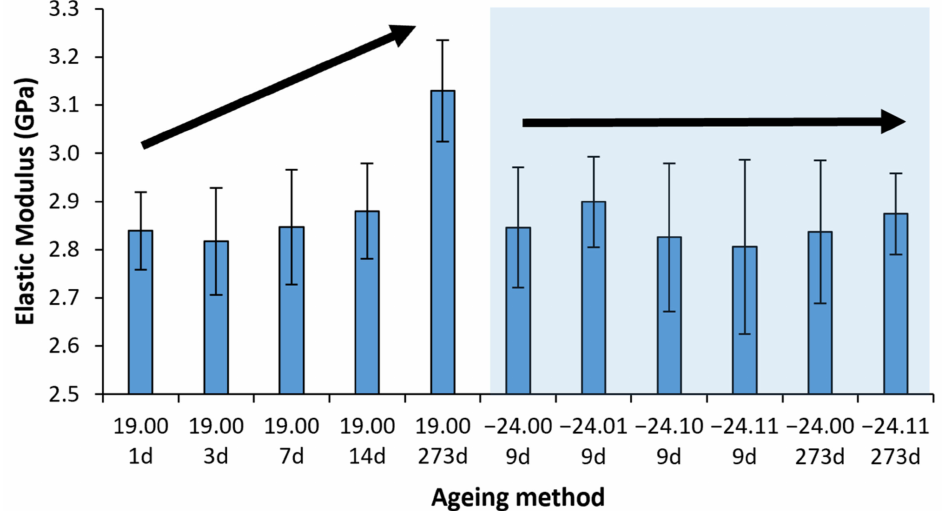
Figure 11. Bar diagram with the average value of the elastic modulus with its mean square error versus the ageing time. The Shadow area shows the frozen sample value interval. Six samples were measured for each ageing conditions and error bars are the standard